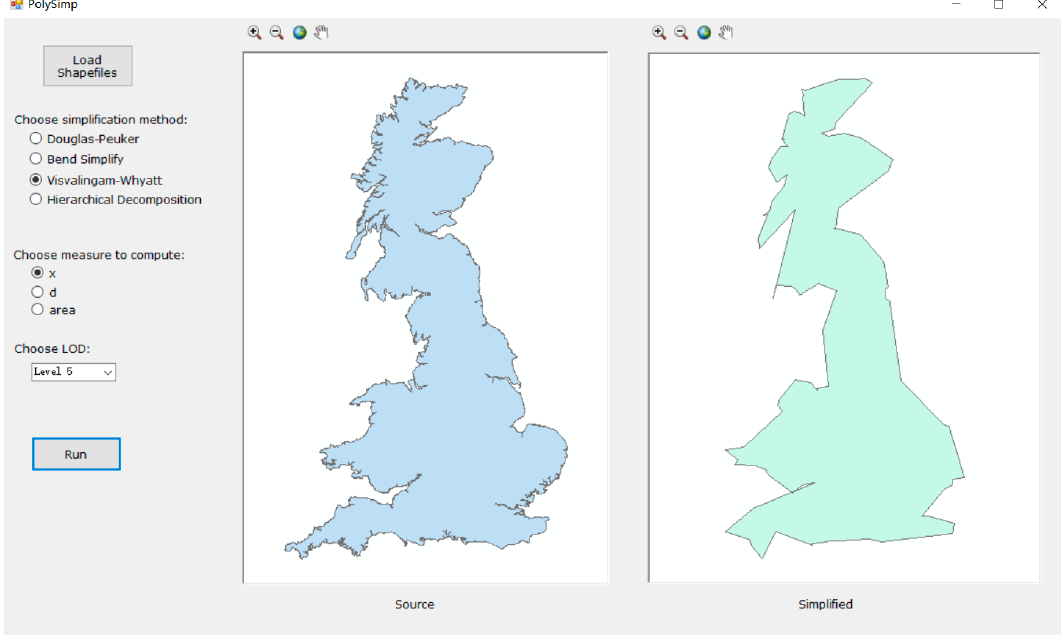
Figure 4. The tool for easily conducting cartographical simplification of polygonal features based on its inherent scaling hierarchies.